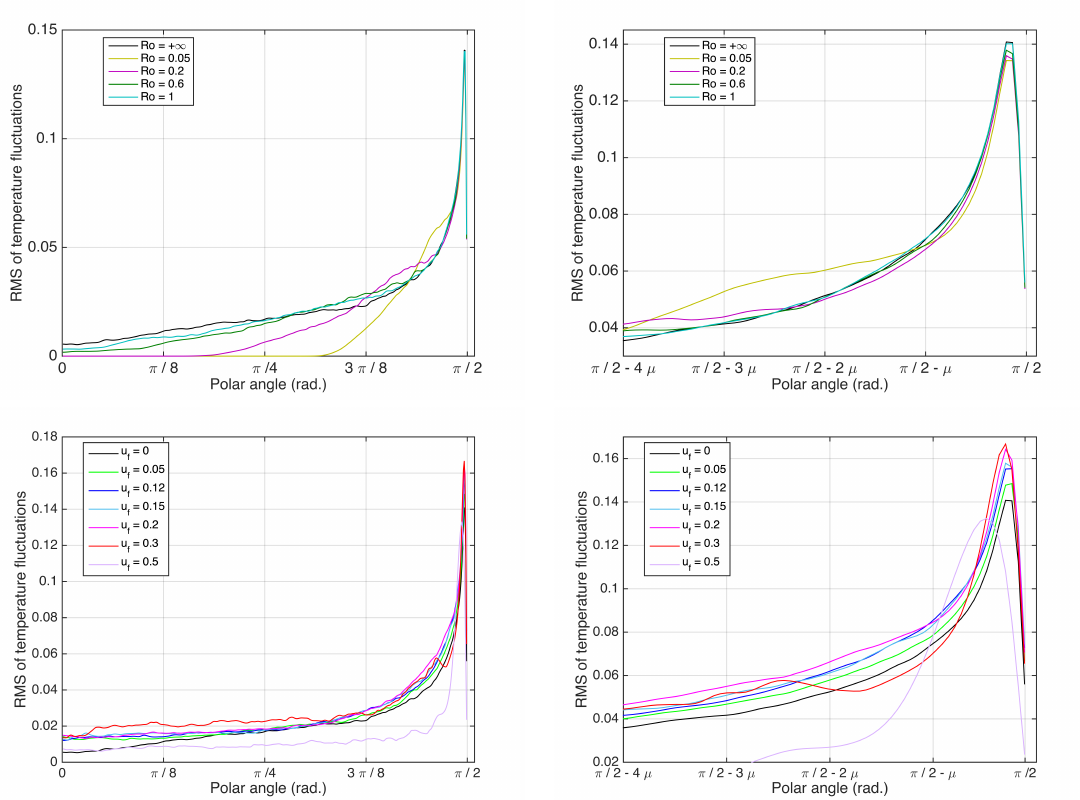
Figure 8. Temperature fluctuations RMS. Top: Method 1 for various values of the Rossby number. Bottom: Method 2 for various values of the forcing U f . Right: Zoom around the equator; µ =